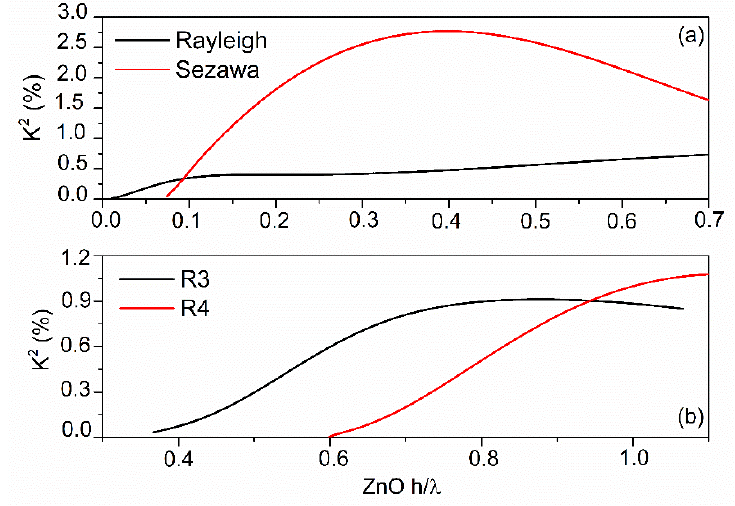
Figure 4. The K 2 dispersion curves of the first four modes for SiO 2 h = 0.033·λ.